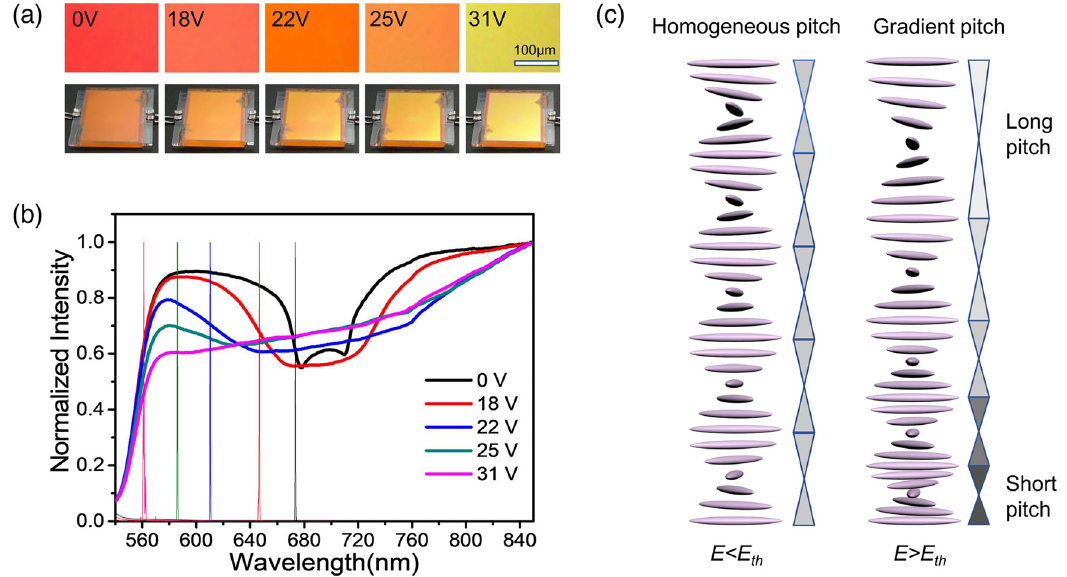
Figure 5: The electric-field-dependent broadening of the selective reflection band and the electrical tunability of the laser ’ s emission